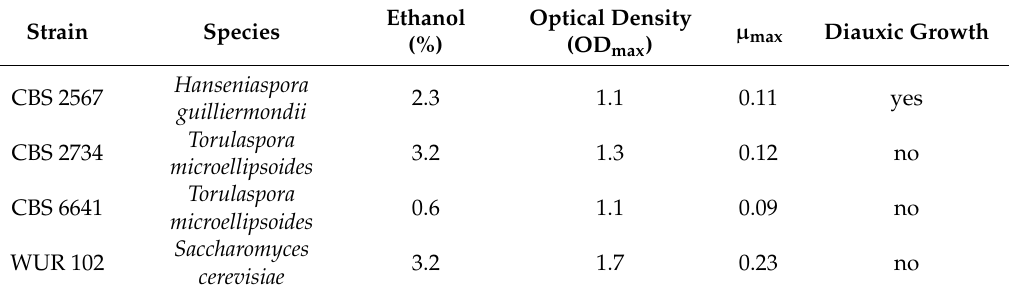
Table 3. Yeast strains from the